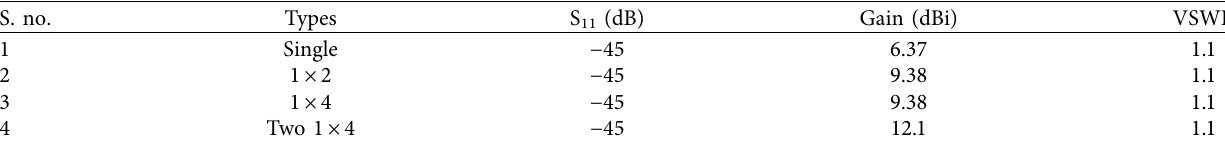
Table 3: Comparison of return loss (S 11 ), gain, and VSWR of projected antennas with diferent confguration. S.